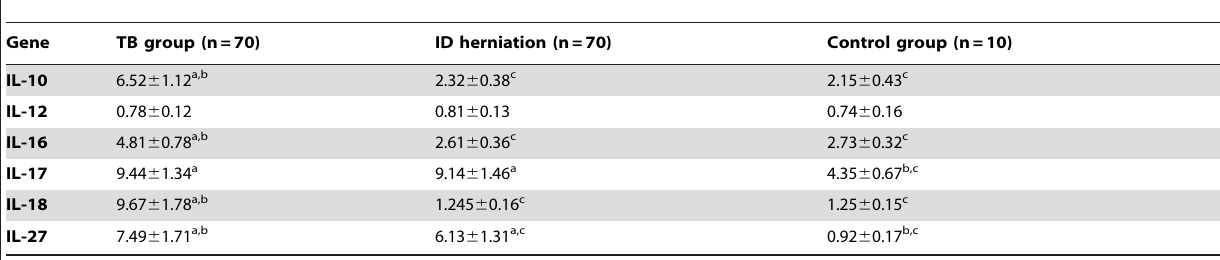
Table 4. The mRNA expression of the ILs in the three groups.